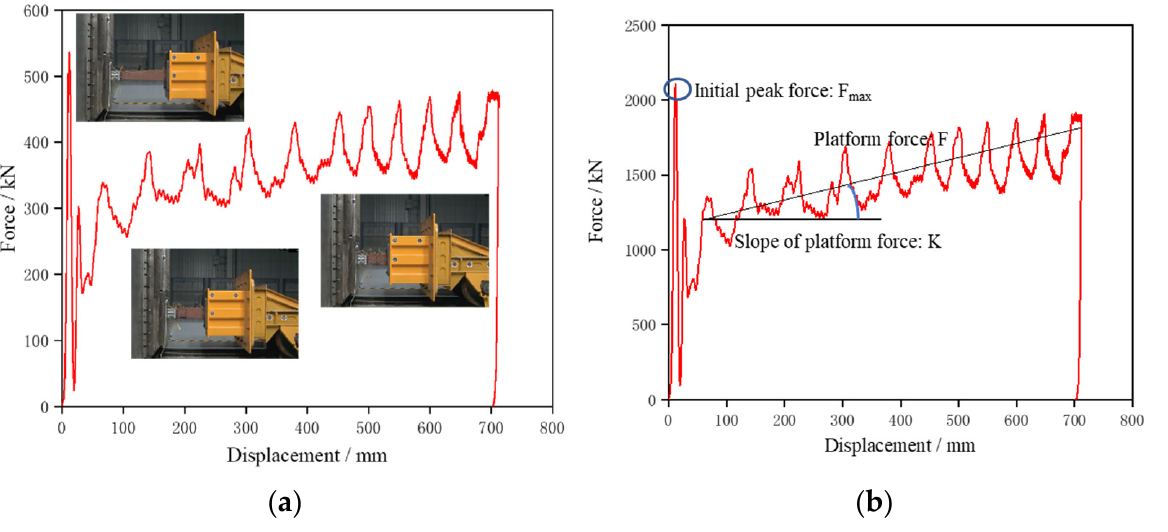
Figure 6. Force–displacement curve of square cone anti-climbing energy-absorbing structure: ( a ) the single square cone structure curve [29], ( b ) force–displacement curve in the model.